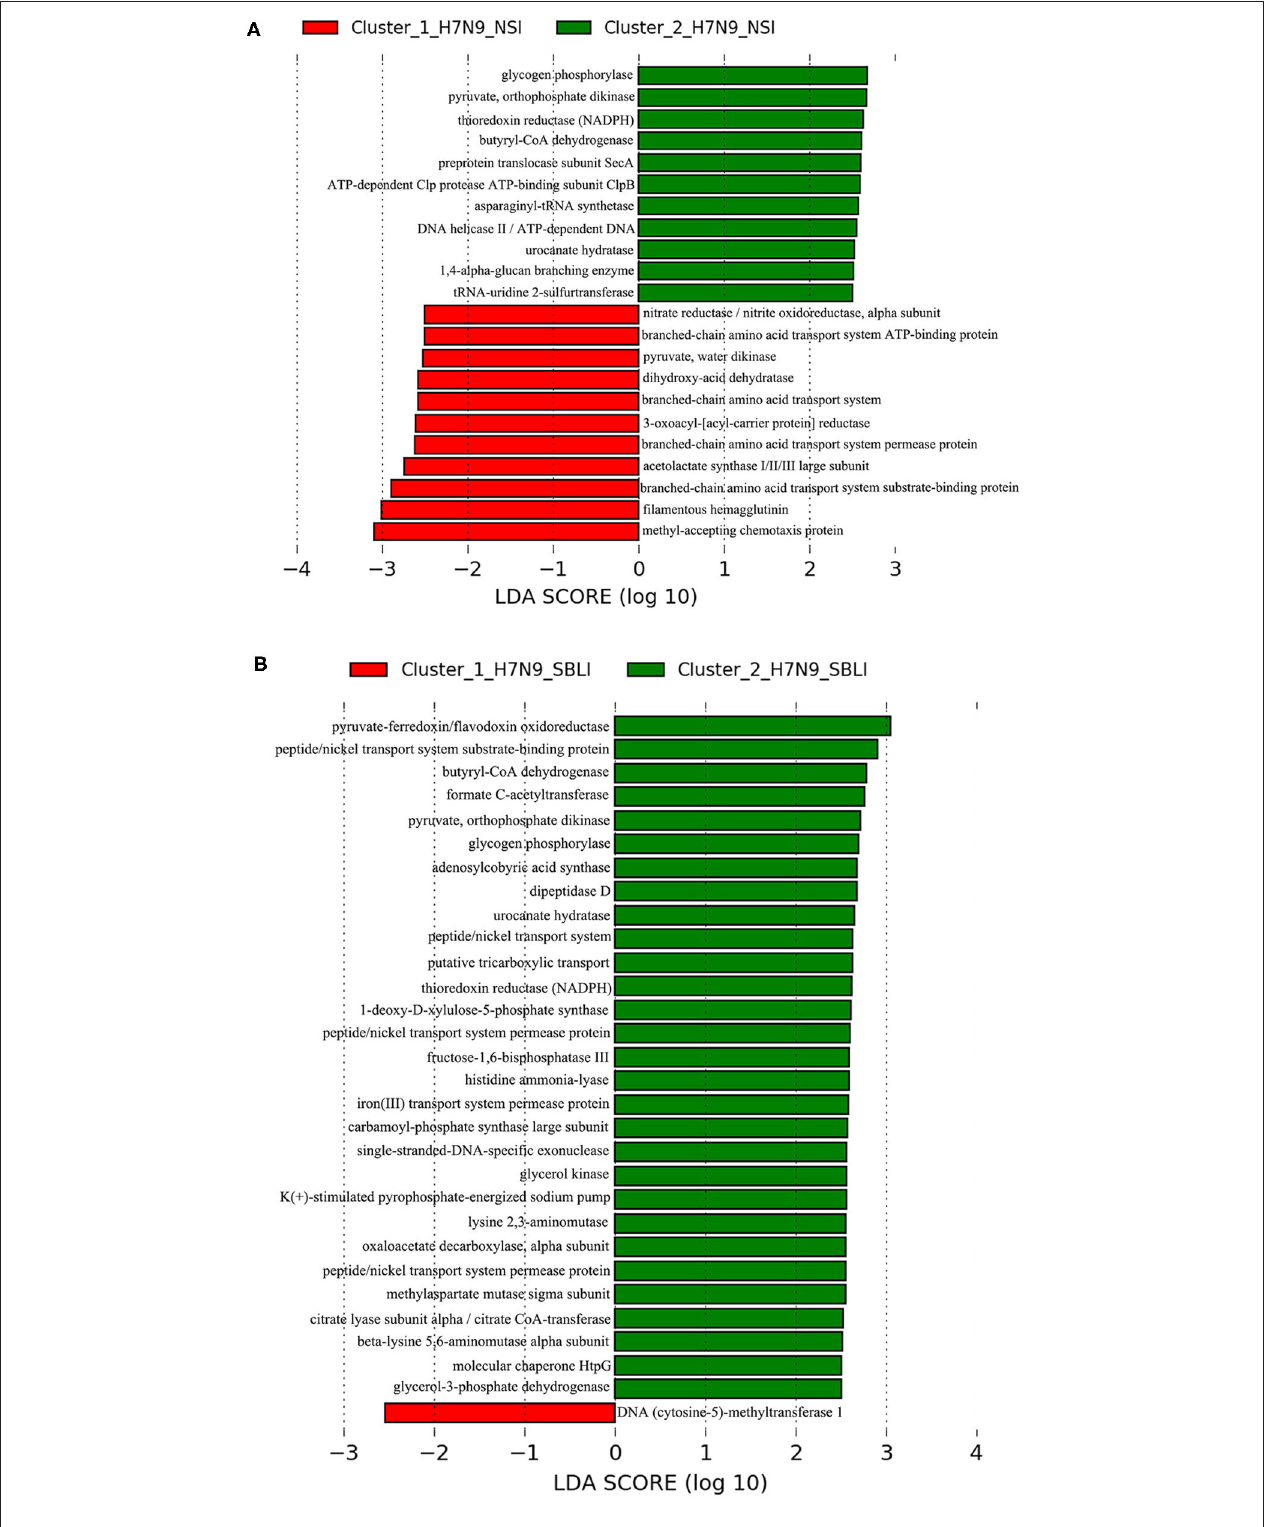
FIGURE 5 | Functional metabolites associated with each of the two clustered OP microbiotas of (A) H7N9_NSI and (B) H7N9_SBLI.